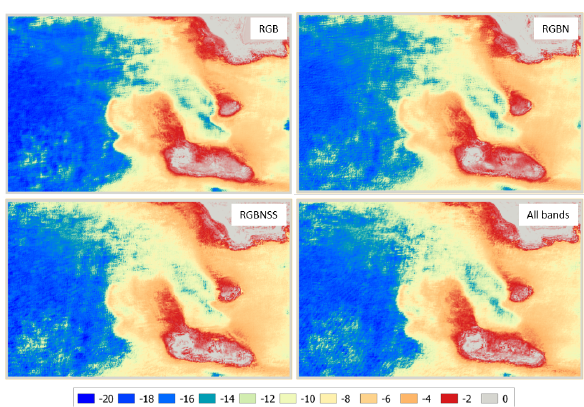
Figure 7. SDB model generated using different number of channels.